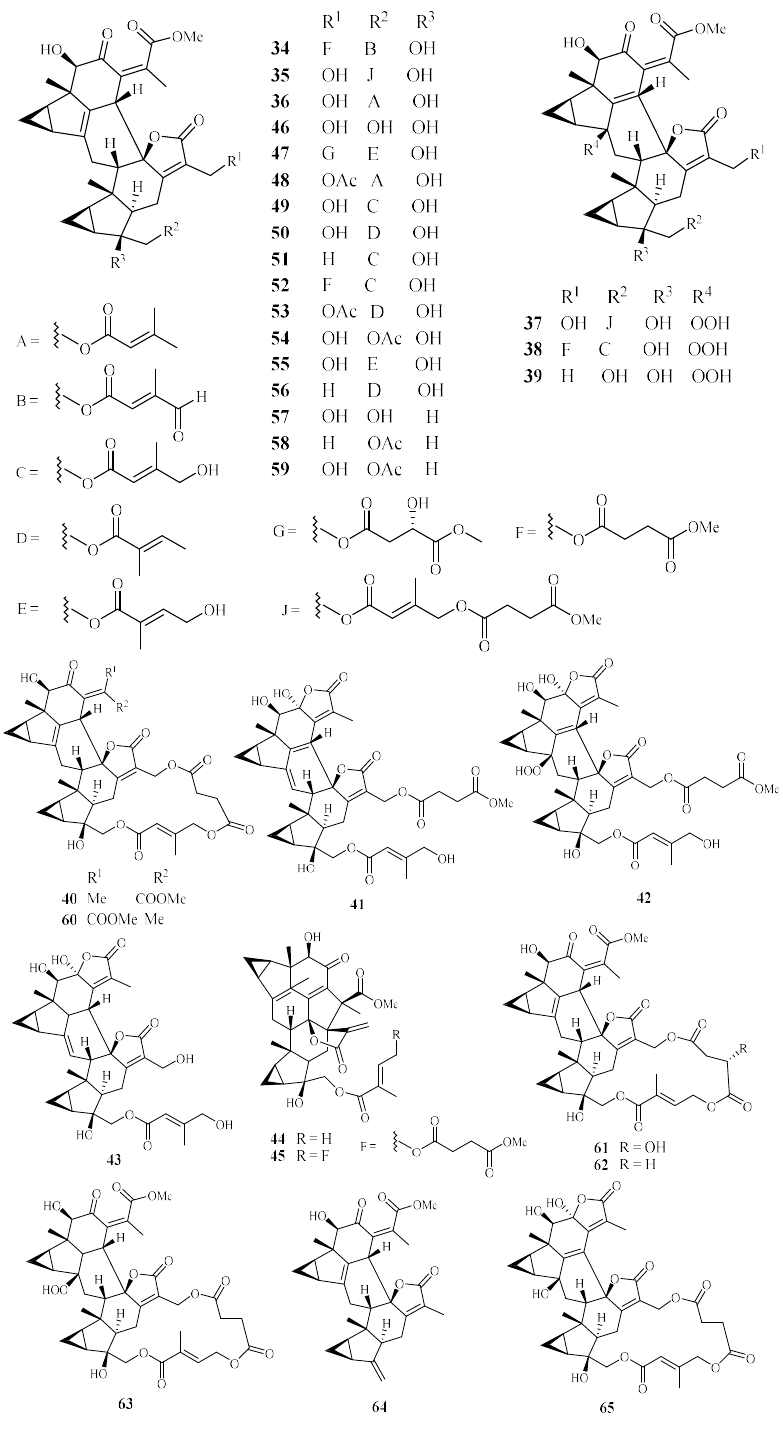
Figure 9. Compounds from Chloranthaceae plants.